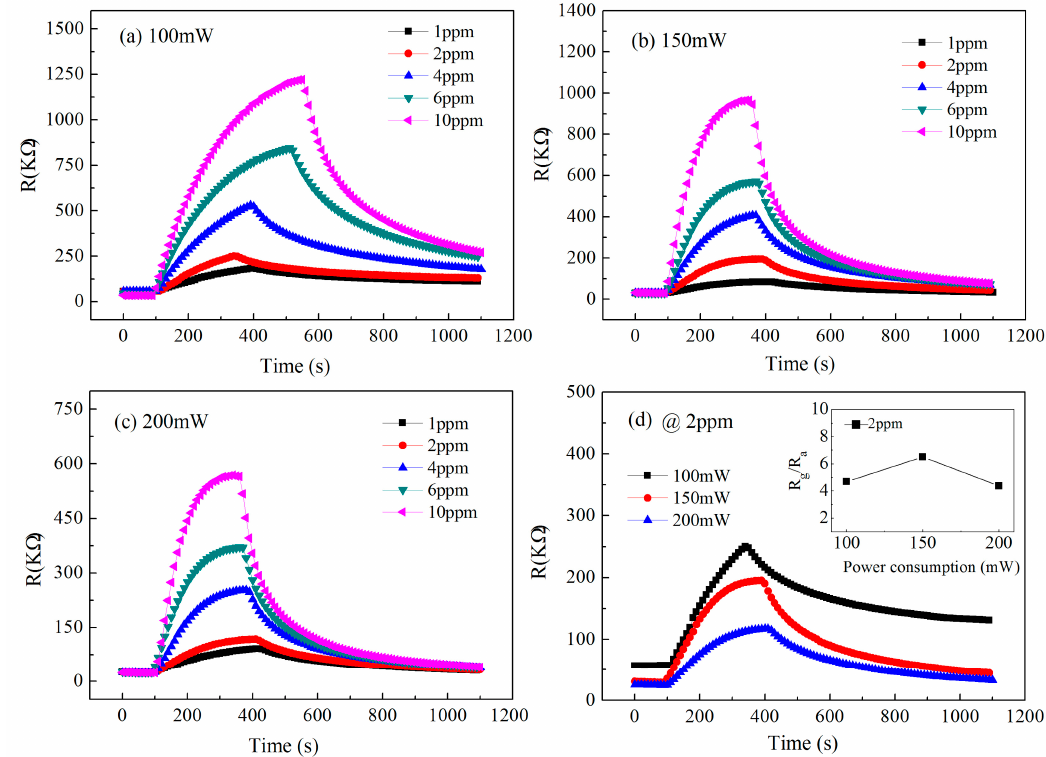
Figure 9. Gas sensing response characteristic curves of the micro hotplate sensor detecting low concentration NO 2 at different power consumptions of ( a ) 100, ( b ) 150, and ( c ) 200 mW, and ( d ) at a fixed concentration of 2 ppm.